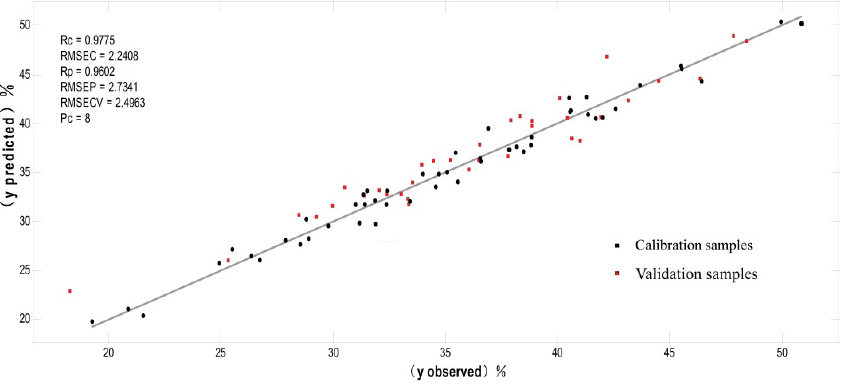
Fig. 8. Correlation diagram of polysaccharide